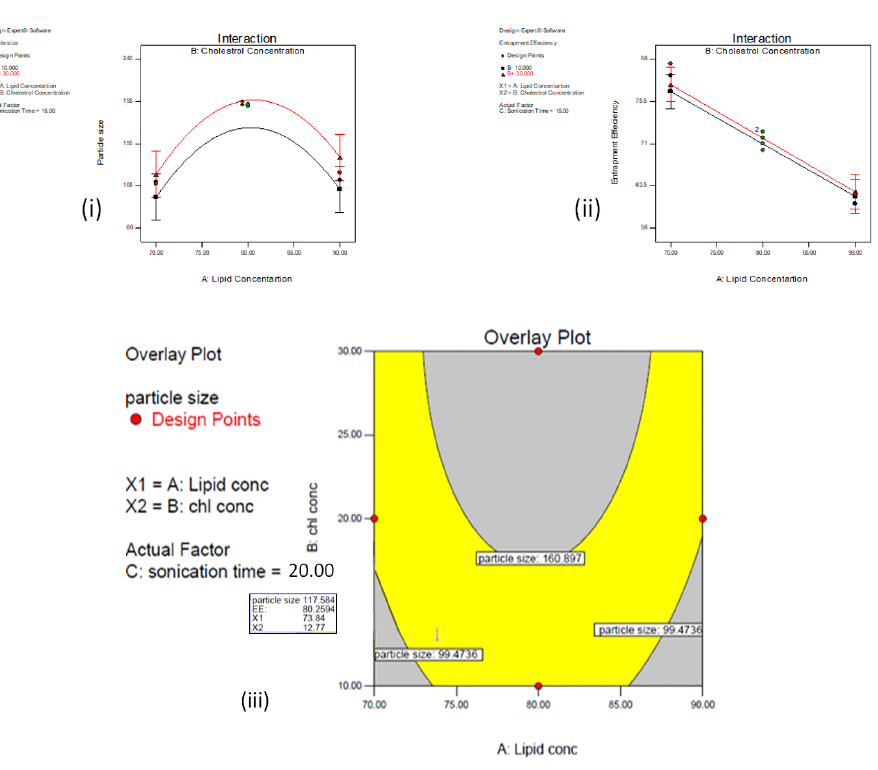
Figure 3. Interaction plot for ( i ) particle size, ( ii ) entrapment efficiency and ( iii ) overlay plot.